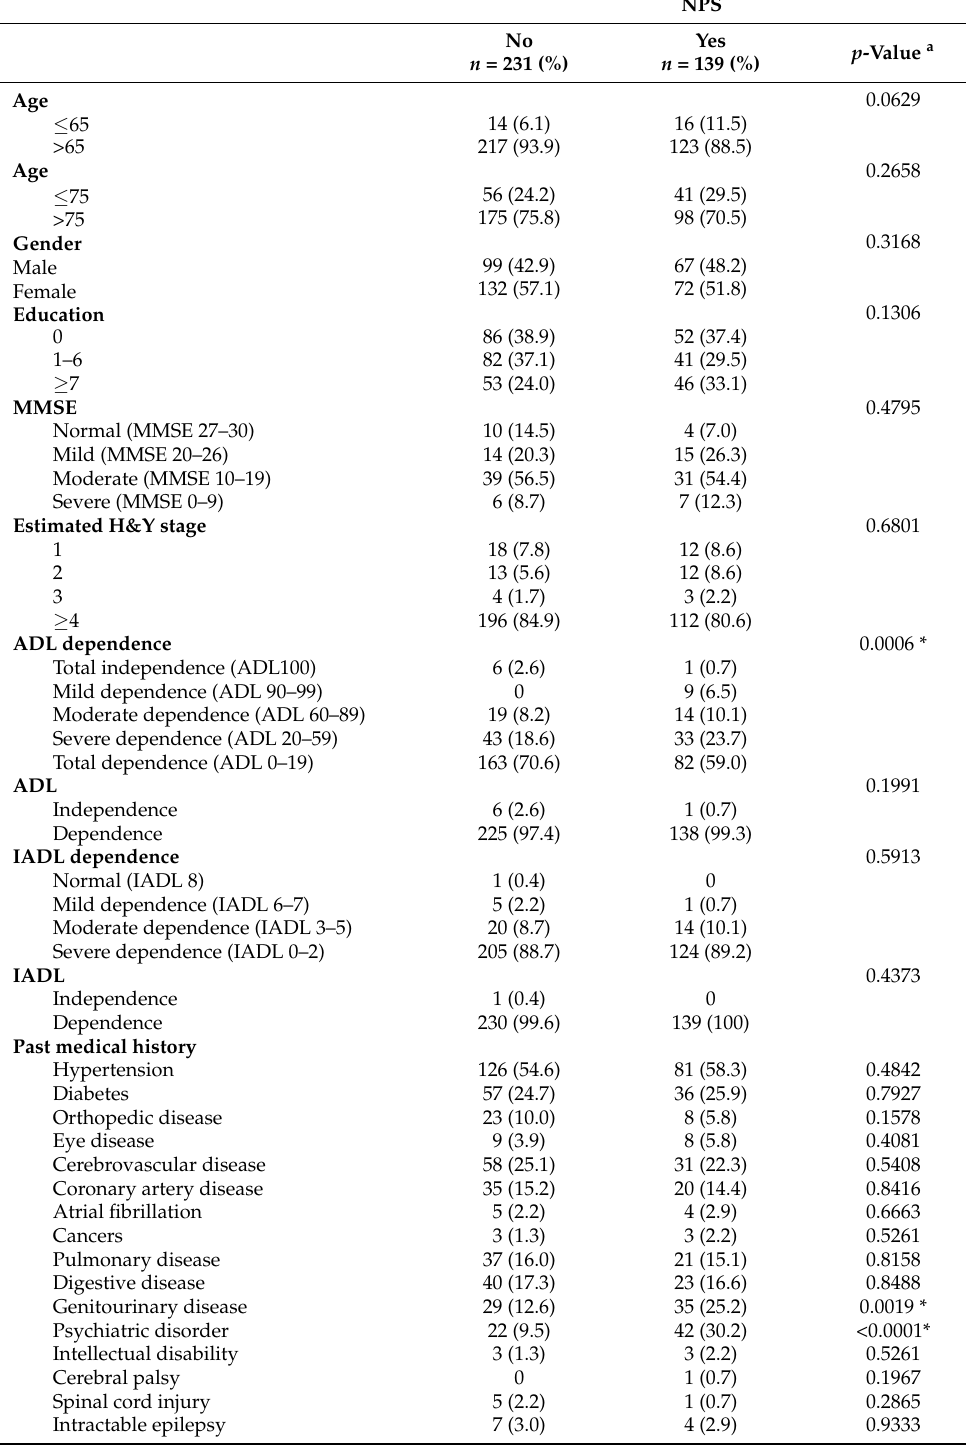
Table 3. Association of PD severities and MMSE, NPS, IADL, and